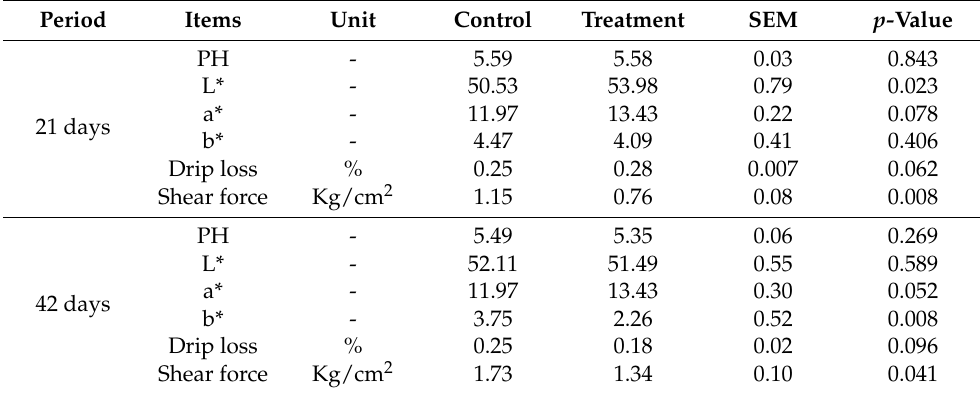
Table 4. Effects of lecithin on the meat quality of broilers at 21 and 42 days. Period Items